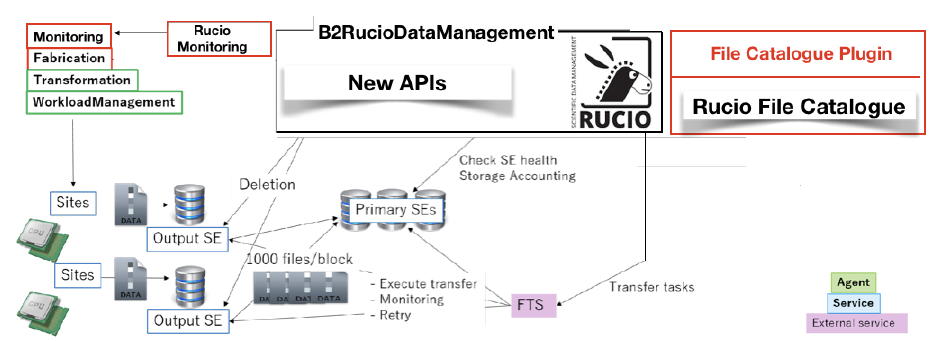
Fig. 5. Belle II Distributed Data Management System at the second step of migration